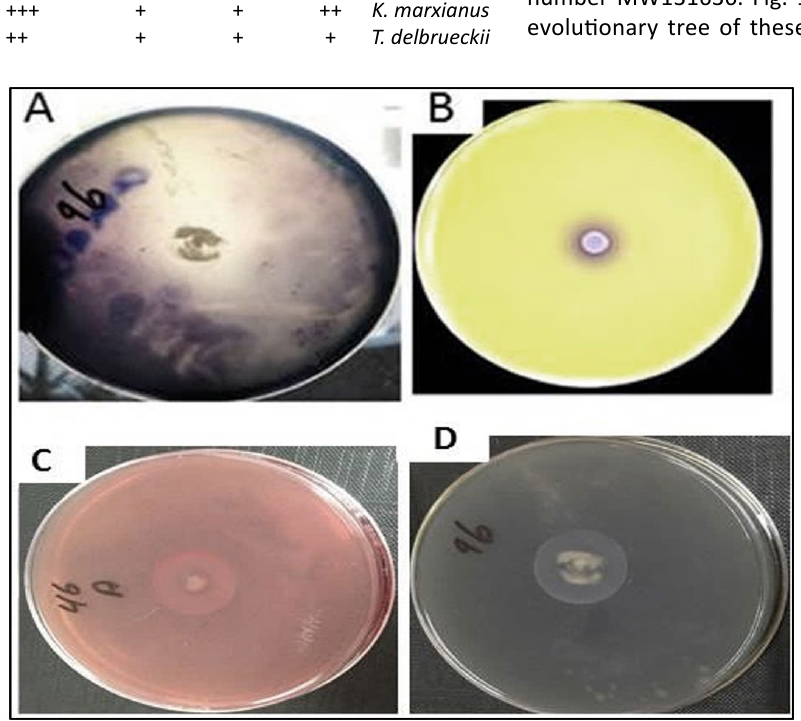
Fig. 2. Illustrates the ability of T. delbrueckii yeast to produce the enzymes that considered biological control. This was done by culturing the yeast on the growth medium that contains the substrate that stimulates the production of the enzyme, which is A- Production of amylase enzyme by culturing yeast on a medium containing starch as a substance B- Production of chitinase enzyme by culturing yeast on a medium containing colloidal chitin as the substrate C- Production of cellulase enzyme by culturing yeast on a medium containing CMC as a substrate. D- Protease enzyme production by culturing yeast on growth media containing